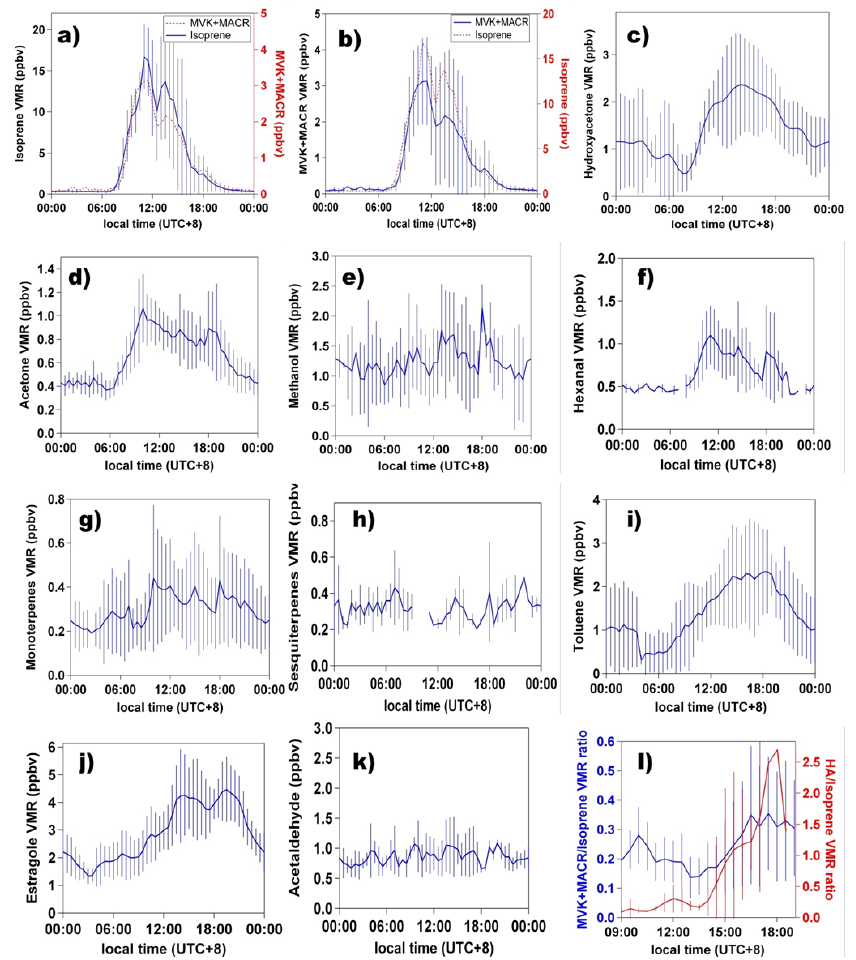
Fig. 3. Daily average diurnal mixing ratios of dominant VOCs (a–k) at the oil palm plantation; ratios of isoprene oxidation products (l). Error bars denote day-to-day variability (1 standard